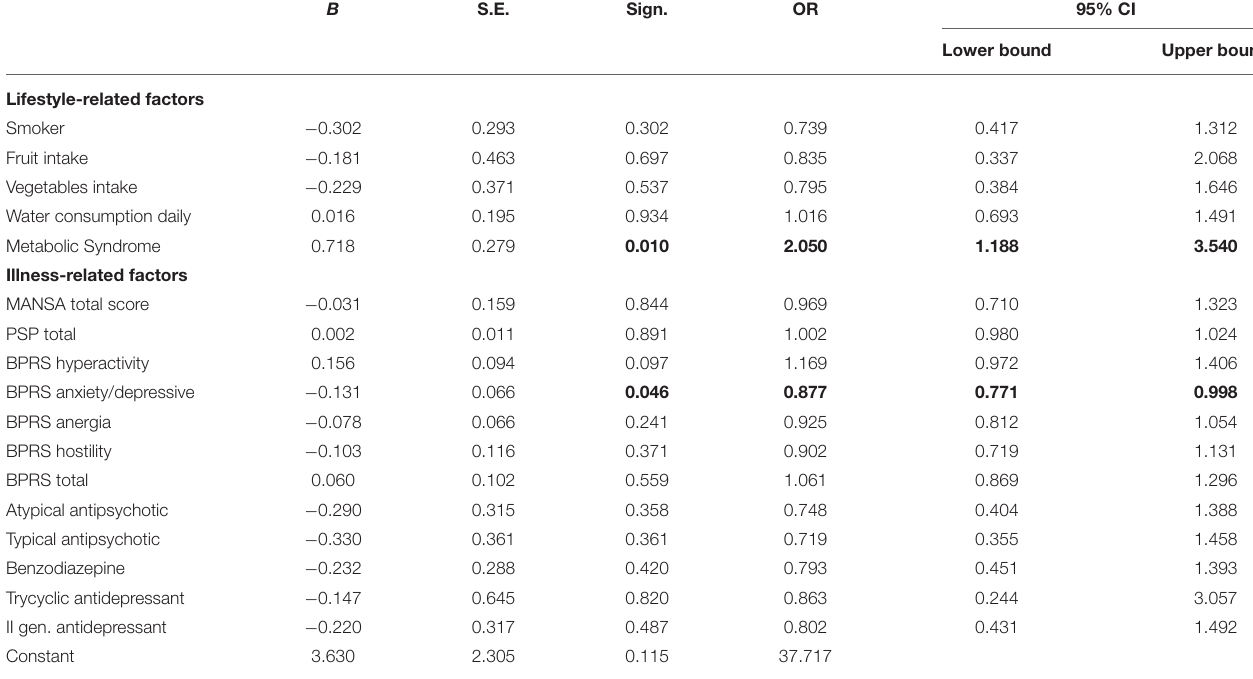
TABLE 4 | Predictors of practicing regular physical activity.